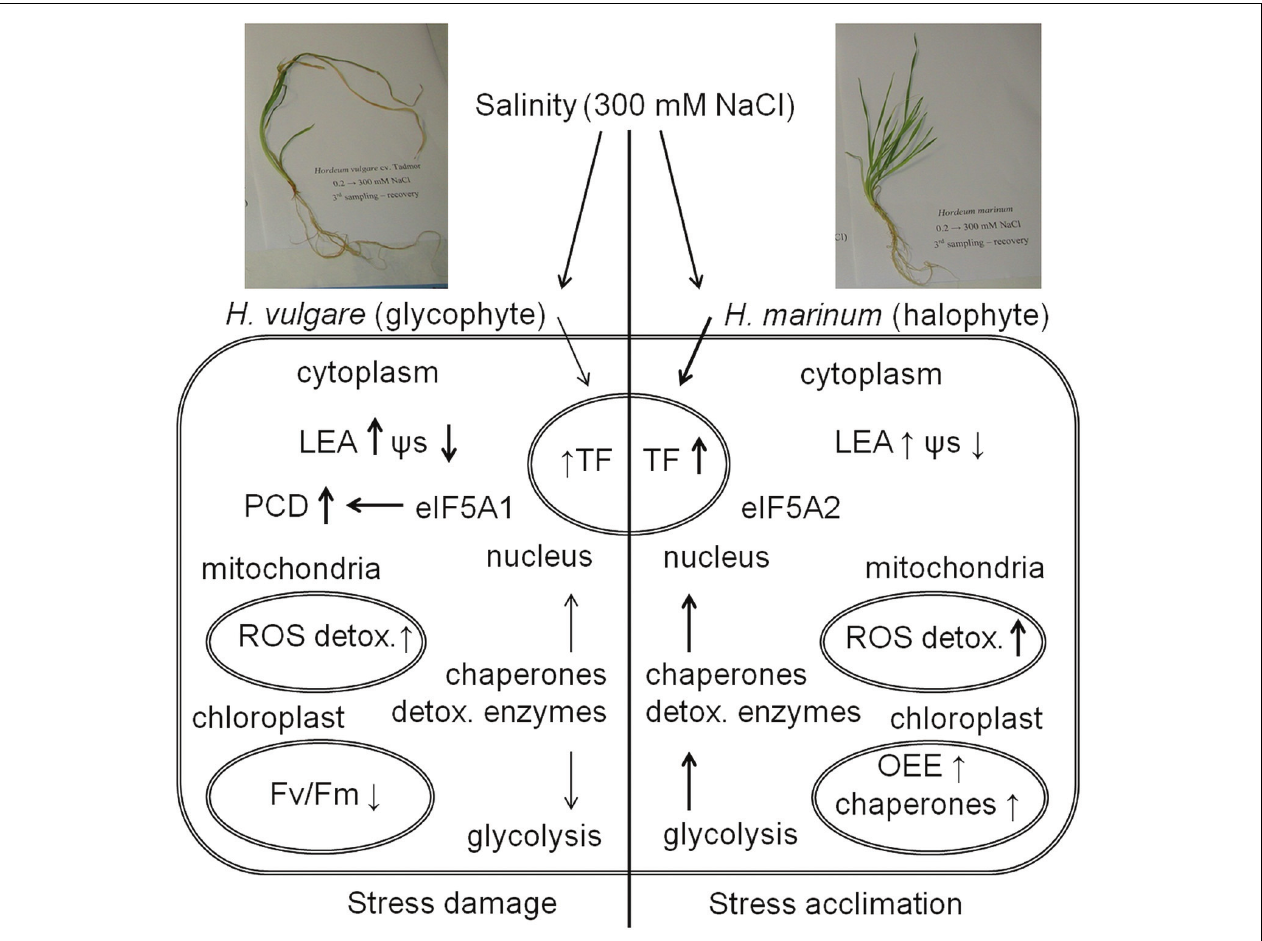
FIGURE 6 | A schematic summary of plant response to high salinity (300 mM NaCl) in crown tissues of H. vulgare , a glycophyte, and H. marinum , a halophyte. ↑ means an increased protein relative abundance in salt-treated variant with respect to control while ↓ means a decreased protein relative abundance in salt-treated variant with respect to control. The intensity of the arrows indicates quantitative differences in physiological characteristics and protein levels between H. vulgare and H. marinum . See the abbreviations list and the text for abbreviation